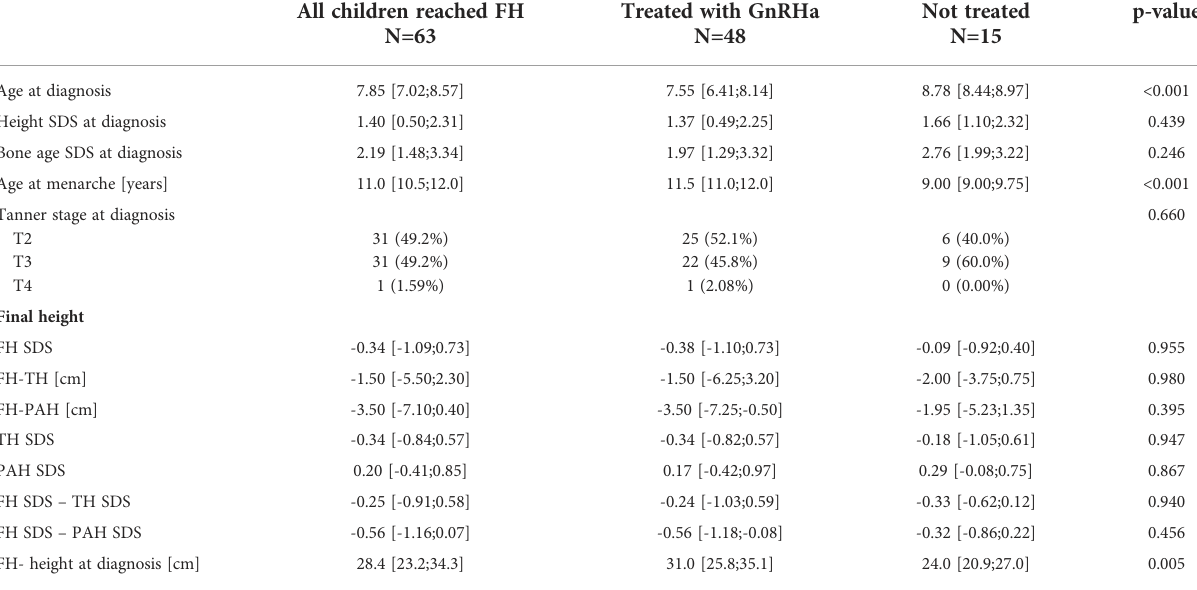
TABLE 3 Comparison between treated and untreated girls with